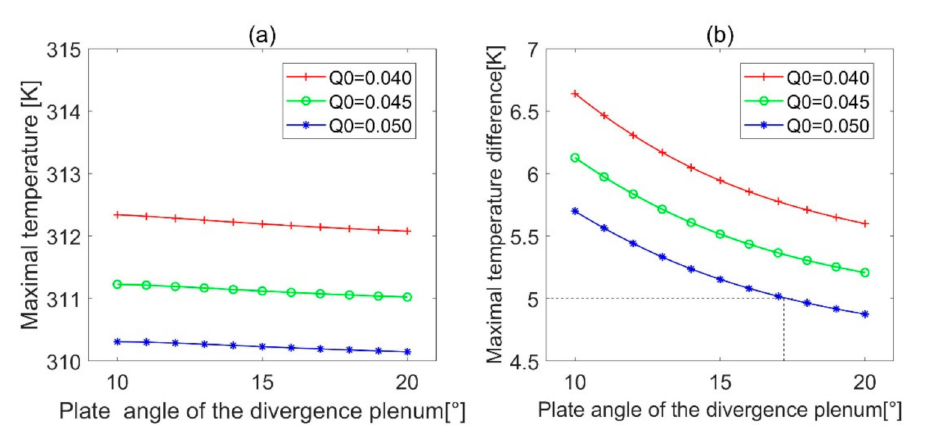
Figure 10. The effect of plate angle of the divergence plenums on the temperature distribution for various inlet airflow rates: ( a ) effect on maximal temperature, ( b ) effect on maximal temperature difference. ( d 0 = 1 mm, θ cp = 15 ◦ , w dp = 5 mm, w cp = 5 mm).